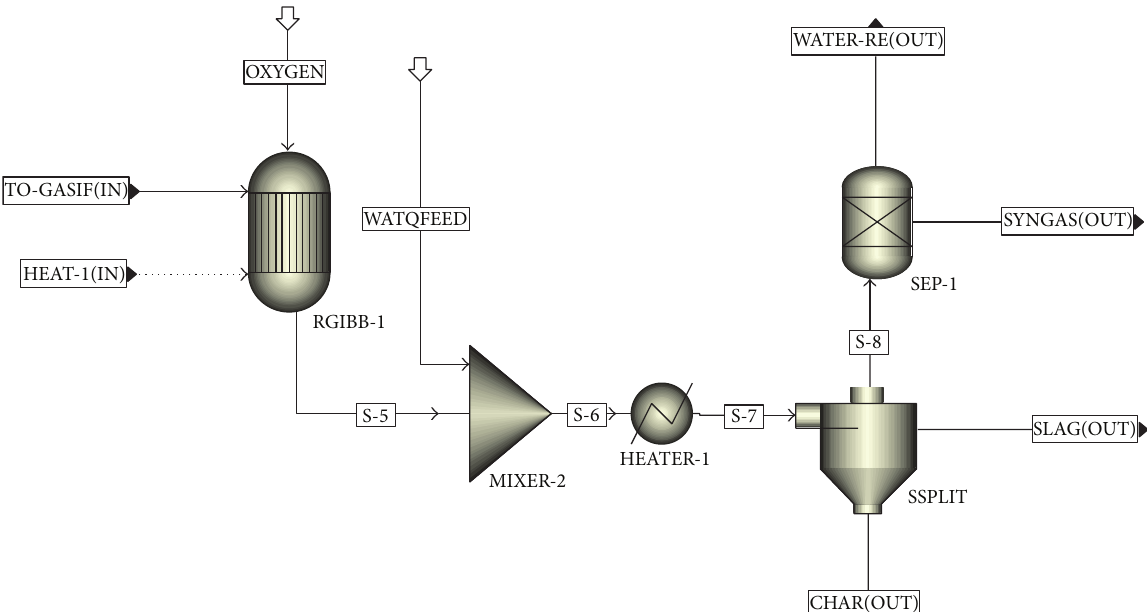
Figure 6: Aspen Plus GASIFIC hierarchy diagram to simulate the gasification stage of coal-GNS process. Flow sheet for dry feeding technology.